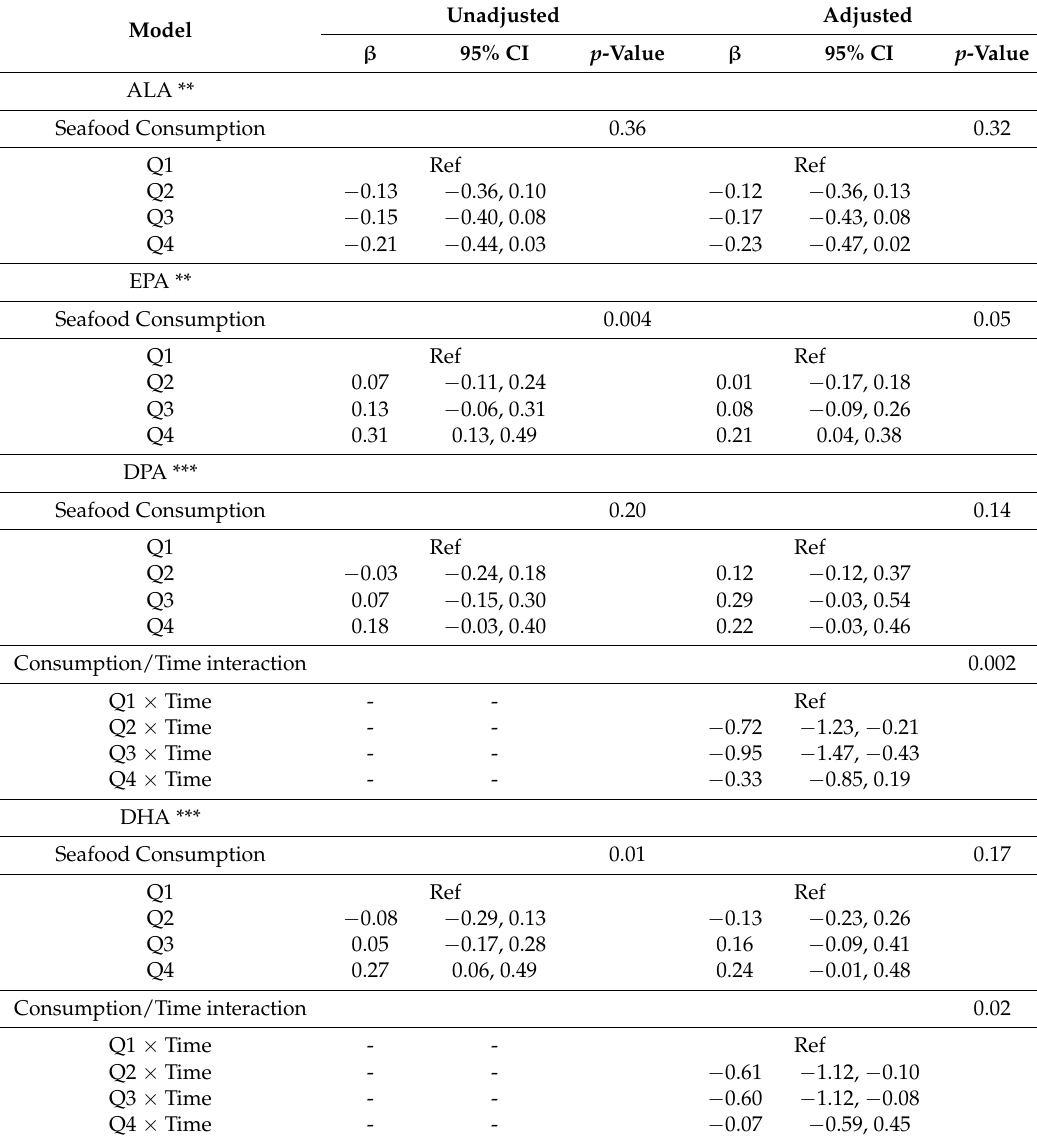
Table 6. Linear regression models modeling for seafood consumption (measured in quartiles of ounces of seafood consumption per month *) as a predictor for blood levels of ALA, EPA, DPA, and DHA. Model